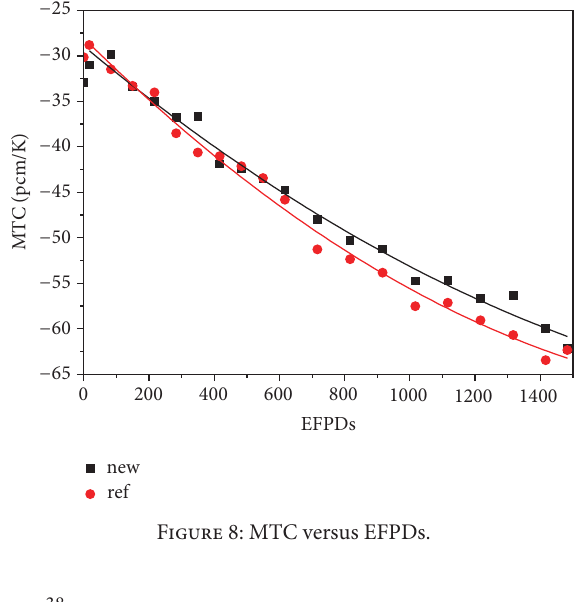
Figure 8: MTC versus EFPDs.